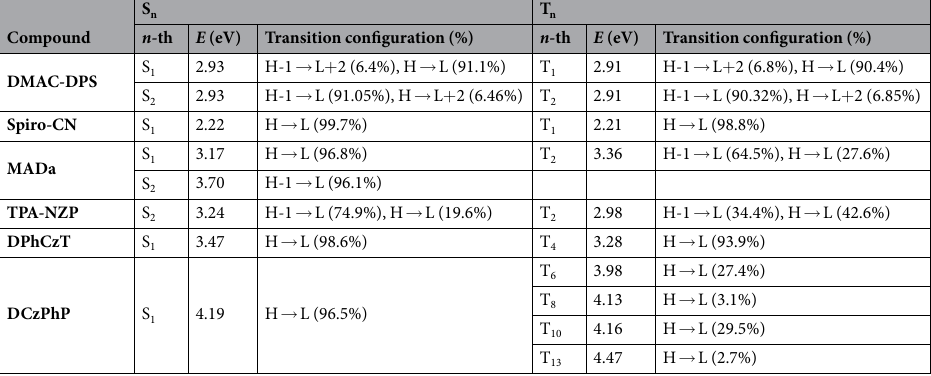
Table 1. Excitation energy ( E in eV) and transition configuration of S 0 → S n and S 0 → T n for exciton transformation a . a H, H-1, L, and L + 2 represent HOMO, HOMO − 1 , LUMO, and LUMO + 2 ,